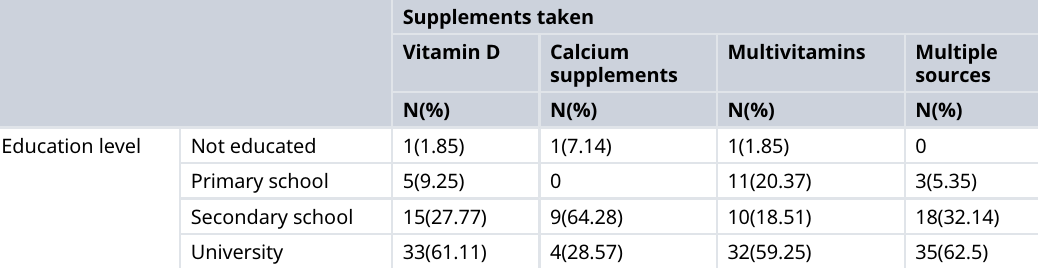
Table 2. Literacy level of participants and supplementation